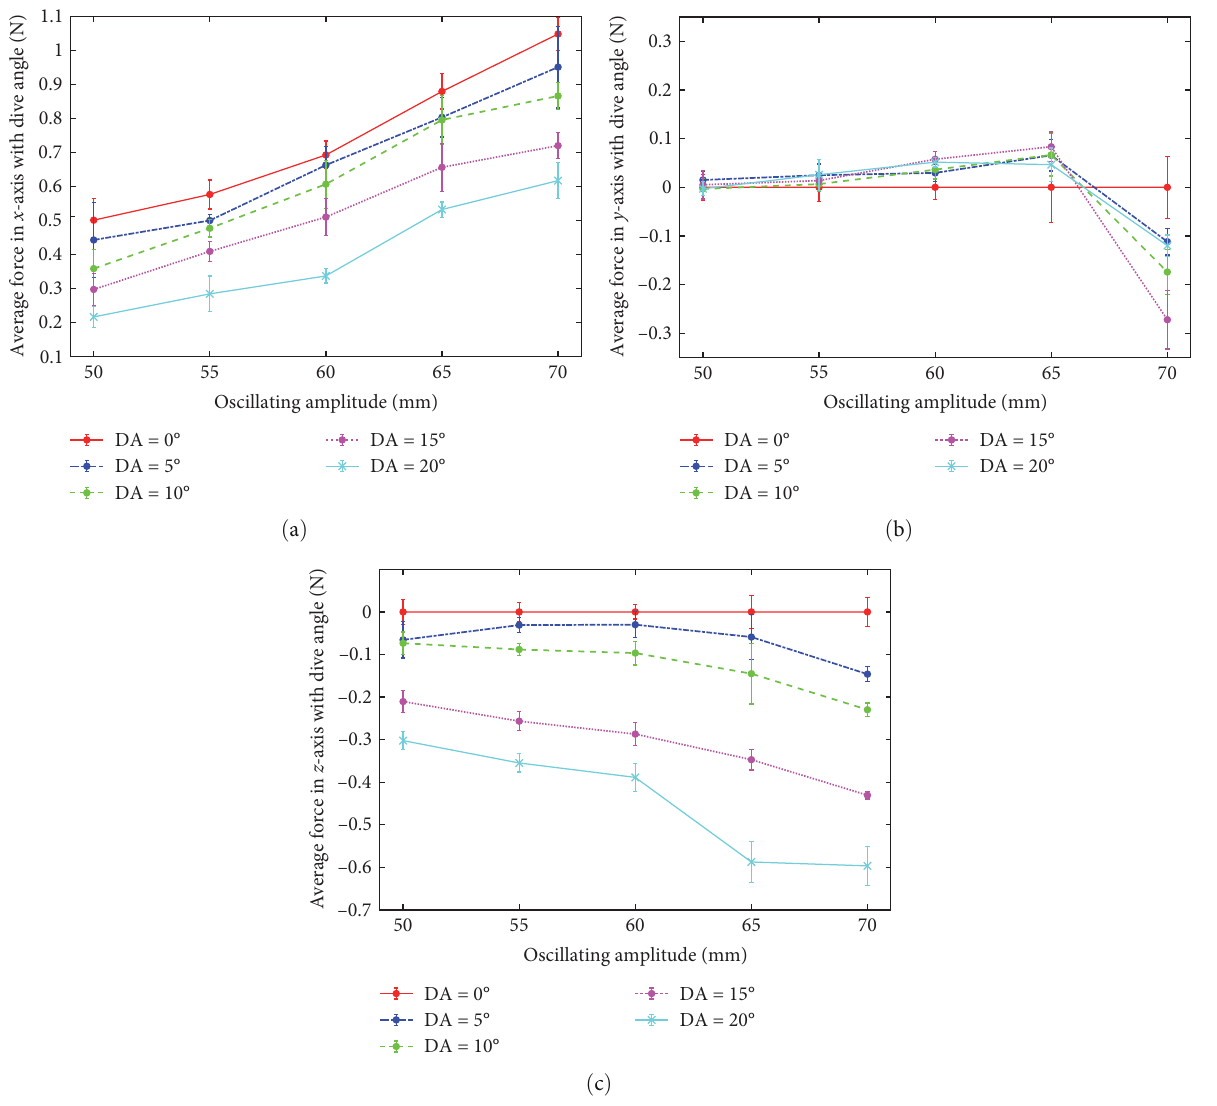
F IGURE 8: F xD ; F yD , and F zD over oscillating amplitude with no wave and no